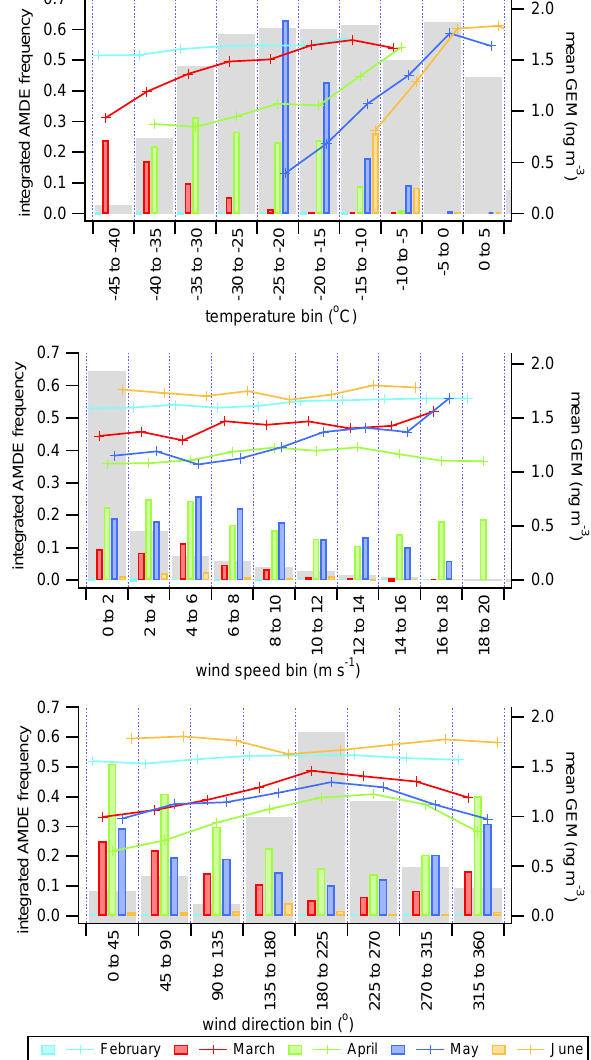
Fig. 2. Integrated atmospheric mercury depletion event frequency ( F AMDE ; coloured bars) and mean gaseous elemental mercury (lines), as a function of temperature, wind speed, wind direction and month for Alert data 1995–2007. For reference, springtime fre- quency histograms of the observed meteorological parameters are included in